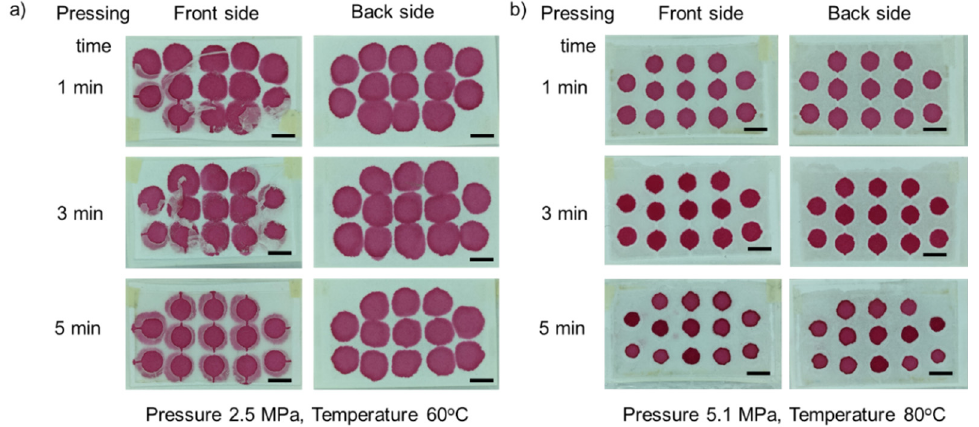
Figure 5. Effect of pressing time: ( a ) under a temperature of 60 ◦ C and a pressure of 2.5 MPa; ( b ) under a temperature of 80 ◦ C and a pressure at 5.1 MPa. The pressing time was varied from 1 to 5 min (left column shows the front side, right column shows the back side). Scale bar is 5 mm.